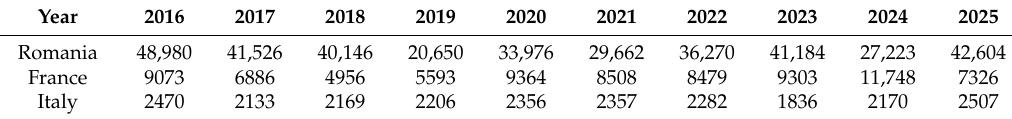
Table 15. Global biodiesel potential (TJ). Source: authors’ own calculation based on [56].